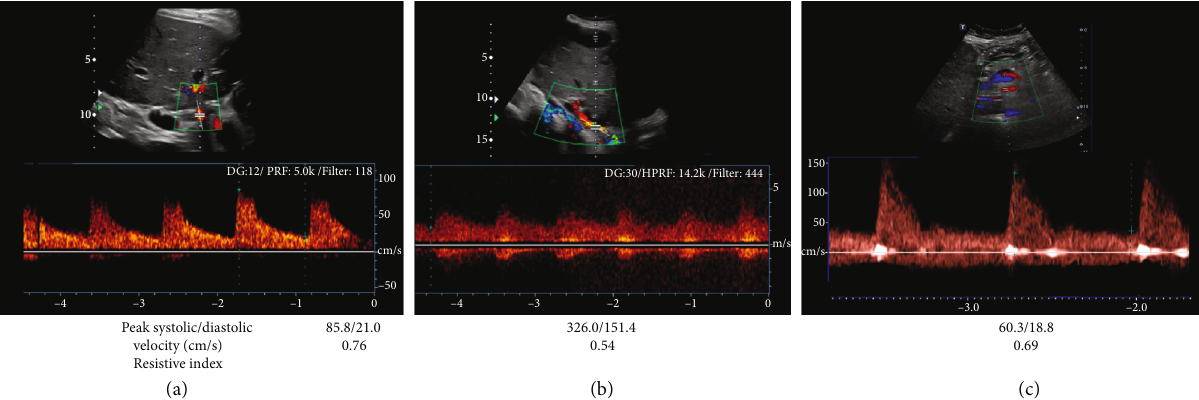
Figure 2: Case 1 baseline Doppler ultrasound with appropriate posttransplant waveforms at the recipient left gastric to graft artery anastomosis (a). Dampened “ parvus tardus ” waveforms concerning for arterial stenosis at the anastomosis on postoperative day 37 prior to intervention. Appropriate arterial waveforms three-year posttransplant after successful primary balloon angioplasty (c).